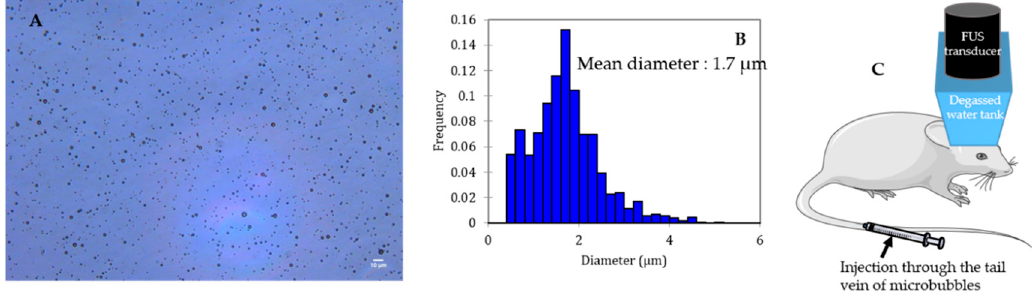
Figure 2. Size distribution characterization of a lipid shelled microbubble solution. Shell composition: 1,2-distearoyl-sn-glycero-3-phosphocholine (DSPC) 9:1 1,2-dimyristoyl-sn-glycero-3-phosphoethanolamine- N -[methoxy(polyethylene glycol)-2000] (DSPE-PEG2000). Core composition: decafluorobutane. ( A ) Microscopic picture of the solution (dilution: 1:10; scale: 10 µm), ( B ) size distribution of the solution, ( C ) schematic representation of BBB opening on mice.